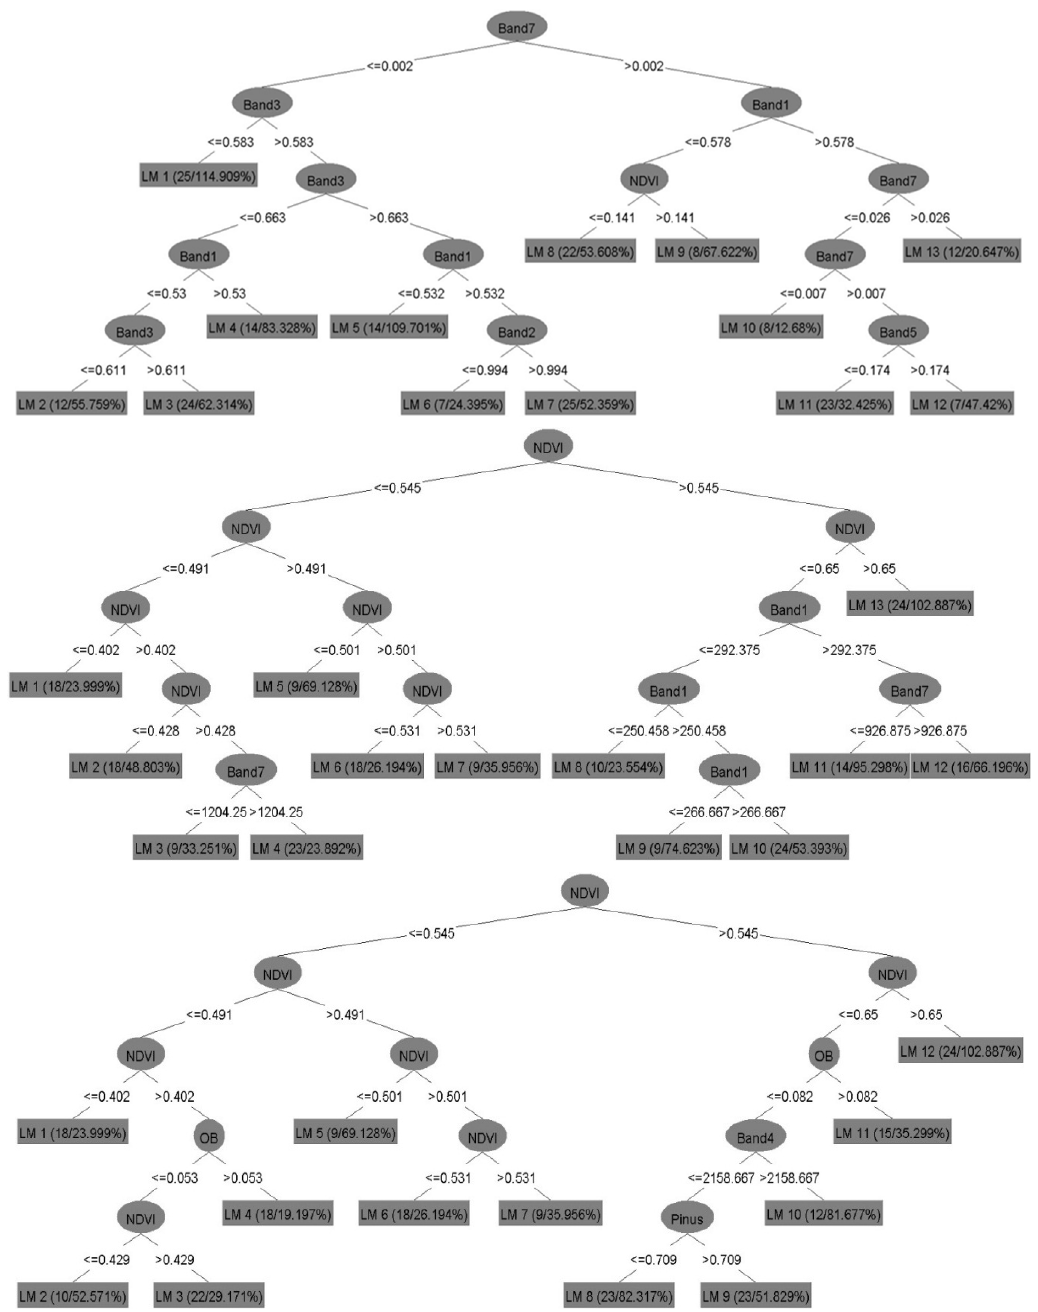
Figure 2. Decision tree obtained using the M5P technique with ToA (upper), SR (middle) and SR with ASG variables (bottom). (Band 1 to 7): of Landsat 5 TM (Thematic Mapper) satellite, (NDVI): normalized difference vegetation index, (OB) tree abundance of other broadleaves species, and (Pinus) tree abundance of pines.